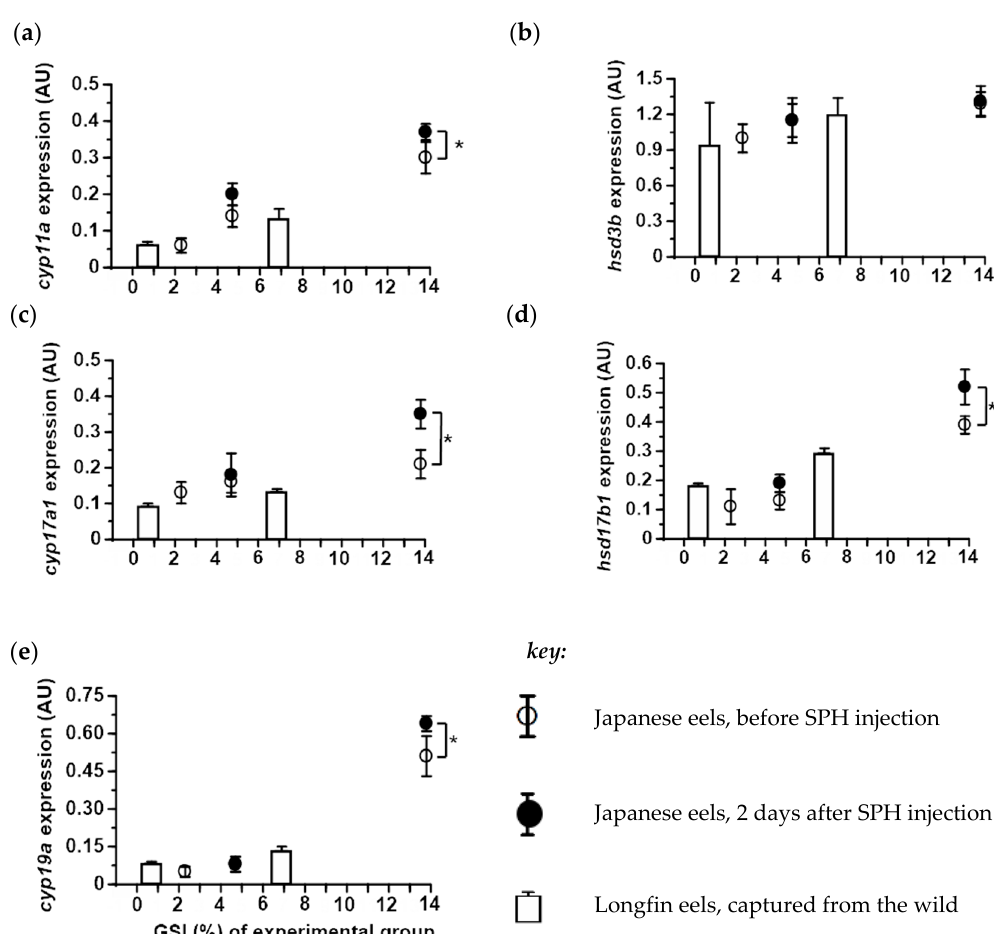
Figure 2. Serum levels of testosterone, T, (a) and estradiol-17 β , E2, (b) in artificially maturing female Japanese eels (circles) and in wild-caught female longfin eels (white columns) during vitellogenesis. Steroid levels in Japanese eels were determined just prior to (open circles) or 2 days after (black circles) exogenous hormone treatment. Stages of ovarian development are as in Figure 1. Values represent mean ± SEM. * P < 0.05 within the same developmental stage.